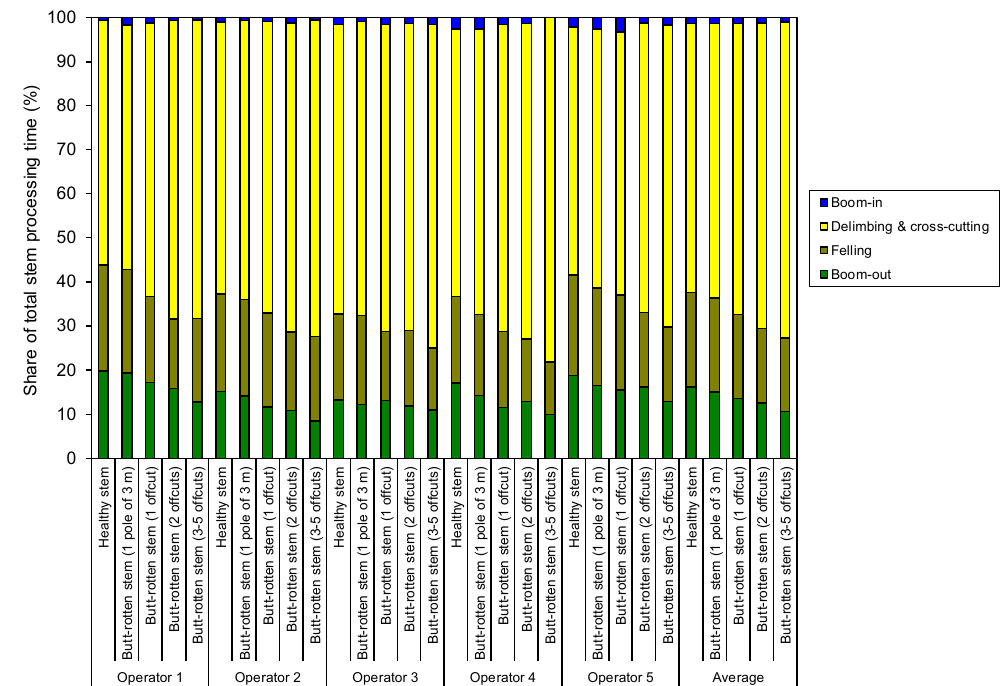
Figure 2. Distributions of the total stem processing time in the cross-cutting practices by harvester operator.